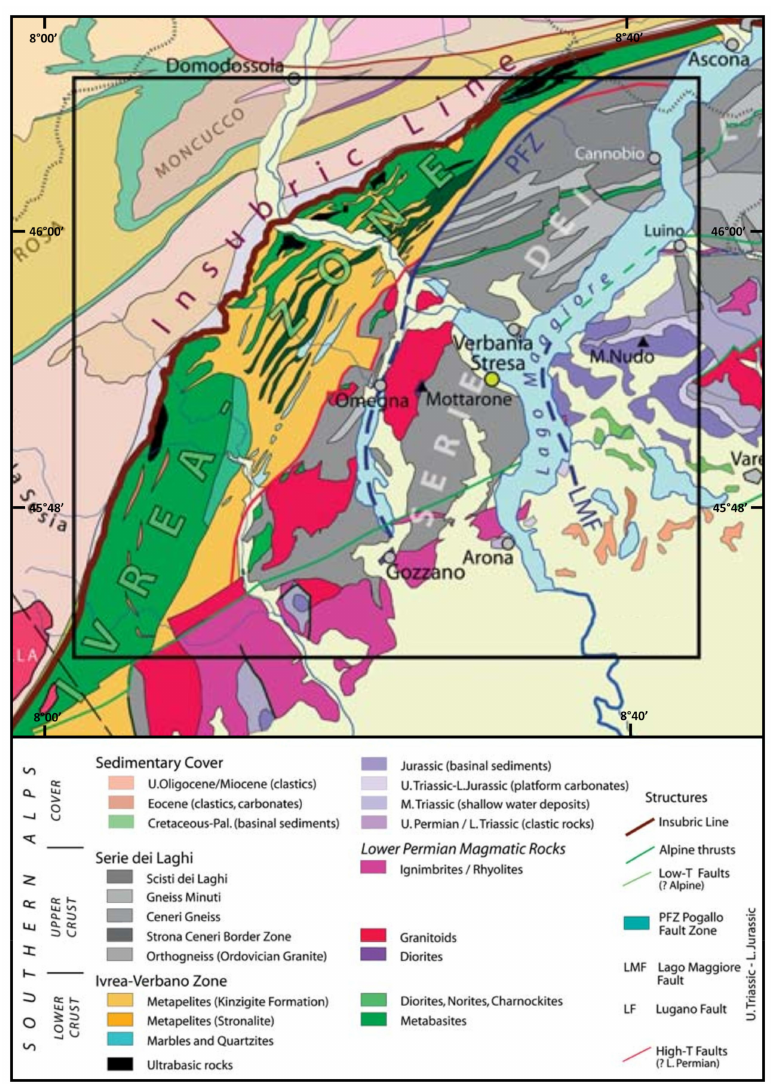
Figure 3. Map of the geological and structural units of the Sesia Val Grande UNESCO Geopark. (modified from Brak et al. 2010)